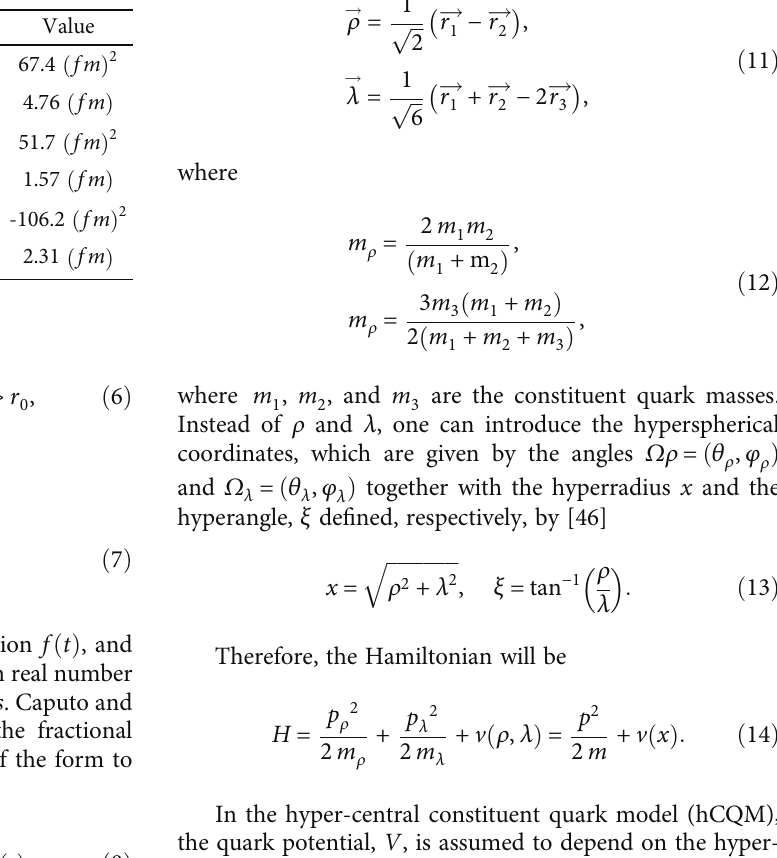
Table 1: Constituent hyper fi ne – potential parameters used in cases I and II [46,